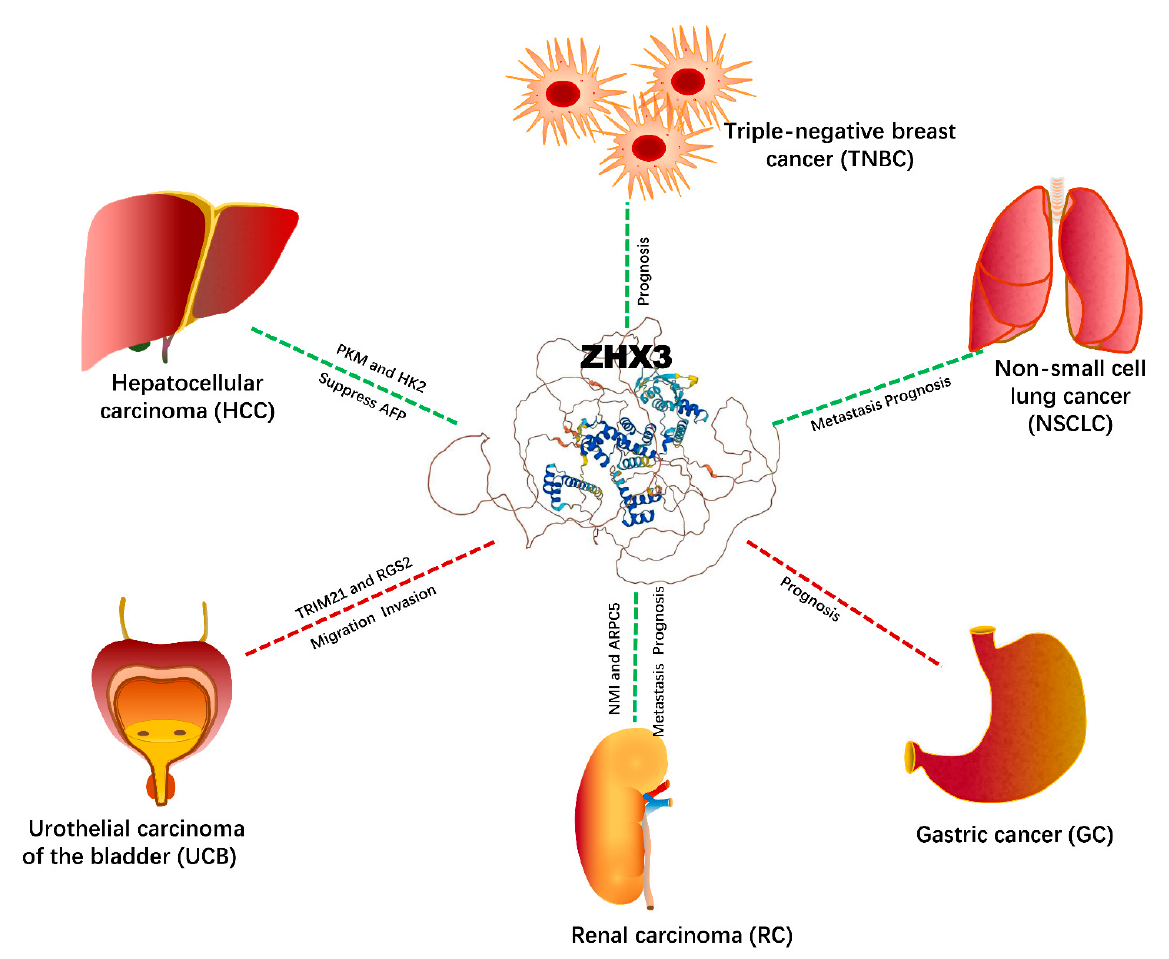
Figure 3. ZHX3 and cancers: biological functions and potential signaling networking